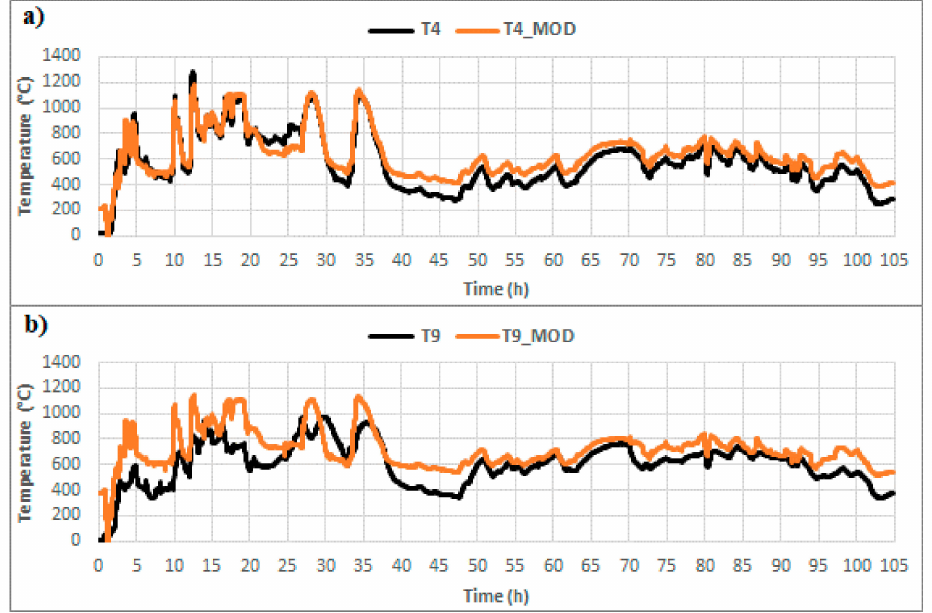
Figure 22. The measured (T) and modeled (T_MOD) temperature behavior, ( a ) temperature T 4 , ( b ) temperature T 9 (Source: own